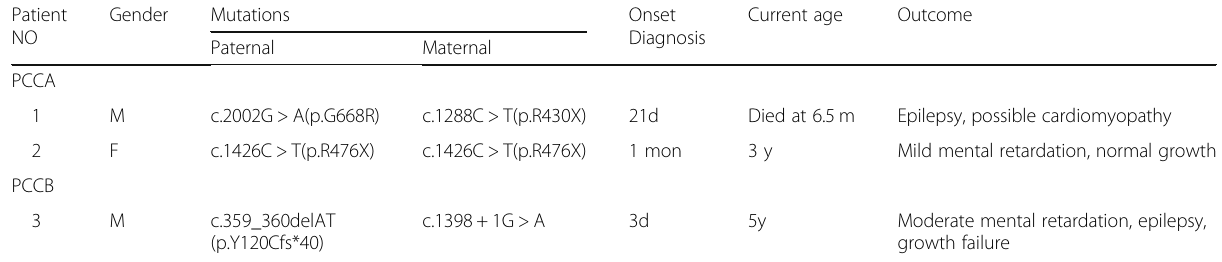
Table 4 Summary of the clinical features and genotypes of the patients with propionic acidemi Patient NO